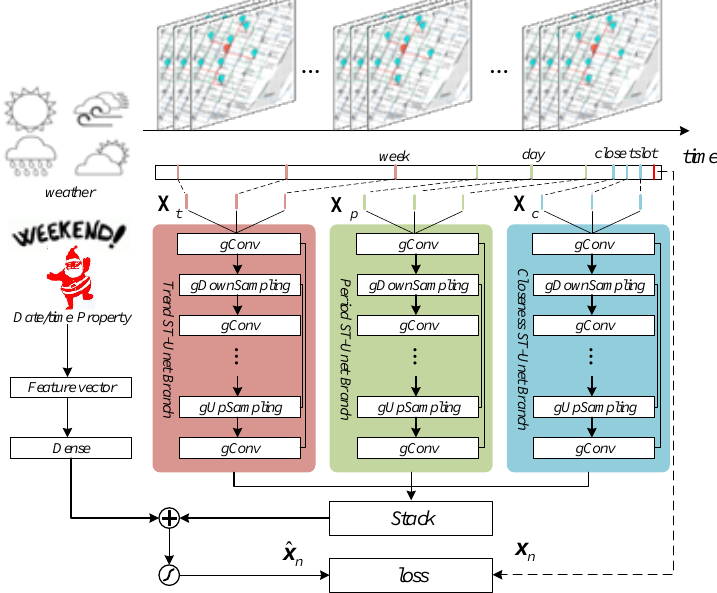
Figure 4. The architecture of the spatio-temporal U-shape network (ST-Unet).